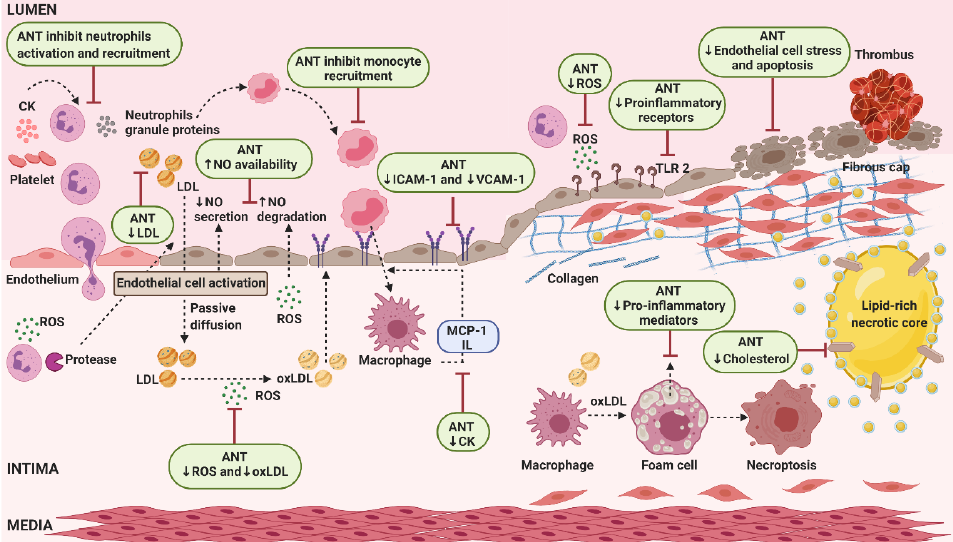
Figure 11. Anthocyanins’ protective effects against atherosclerosis. Anthocyanins’ (ANT) protection occurs in all atherosclerotic stages. ANT decrease plasma low-density lipoprotein (LDL), leading to a reduction in their accumulation in the walls of medium and large arteries. Therefore, ANT indirectly inhibit endothelial cell dysfunction/activation promoted by LDL. Endothelium damage impairs the release of nitric oxide (NO), which together with a local enhanced degradation of NO by increased generation of reactive oxygen species (ROS), decreases NO availability. ANT can increase NO availability by several mechanisms. After activation, endothelia start to express cell adhesion molecules on their surface (ICAM-1, intercellular adhesion molecule-1 and VCAM-1, vascular cell adhesion molecule-1) in order to recruit circulating monocytes to the site of oxidized LDL (oxLDL) accumulation. The expression of these adhesion molecules is downregulated by ANT. In the luminal side, ANT decrease chemokines (CK), which also results in a decline in myeloid cell recruitment. ANT counteract ROS in both the luminal and intimal side, reducing LDL oxidation in vessel wall. During atherogenesis progression, neutrophil-derived granule proteins stimulate macrophage activation to a proinflammatory state which can be inhibited by ANT. Both antioxidant and anti-inflammatory effects of ANT decrease foam cell formation. Moreover, ANT decrease cholesterol by reducing their accumulation in the lipid-rich necrotic core. During the late stages of atherosclerosis, ANT reduce the expression of Toll-like receptor 2 (TLR2) signaling in endothelial cells that regulate neutrophil stimulation of endothelial cell stress and apoptosis. The arrowhead denotes the routes of atherosclerosis progression, whereas the hammerhead represents the effects of ANT. New Zealand White rabbits fed a cholesterol-rich diet have been frequently used in atherosclerosis research, including in studies that examined the effects of anthocyanins. Using this model, it was observed that Concord grape juice decreases serum cholesterol, attenuates platelet